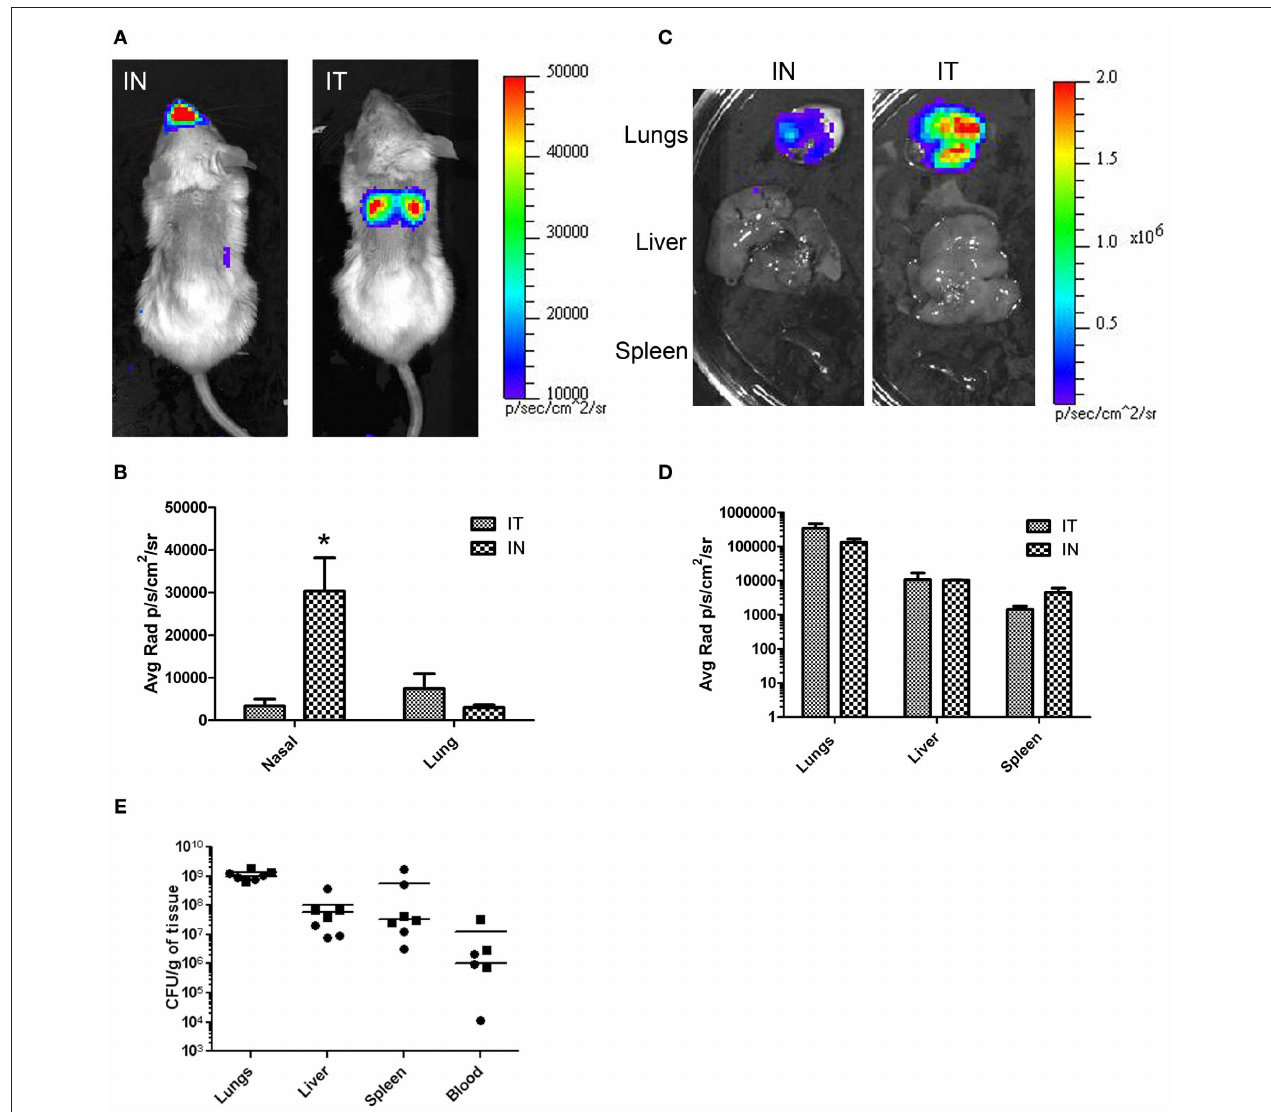
FIGURE 4 | In vivo and ex vivo imaging of B. pseudomallei infections comparing IT and IN inoculation methods. Mice were infected with 10 4 cfu of B. pseudomallei JW280. (A) Mice were inoculated by either IT or IN inoculation methods and imaged using an IVIS Lumina system at 72h. (C) At 72h, mice were euthanized and organs were harvested and imaged.